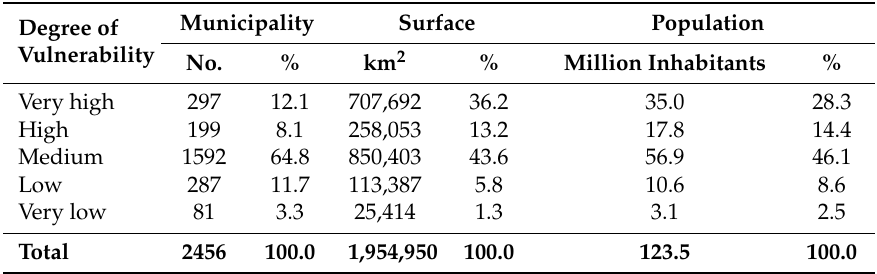
Table 11. Distribution of number of municipalities, surface area, and population by degree of environmental vulnerability to